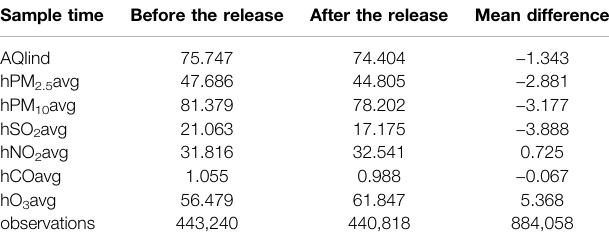
TABLE 1 | Comparison of air quality indexes before and after (mean). Sample time Before the